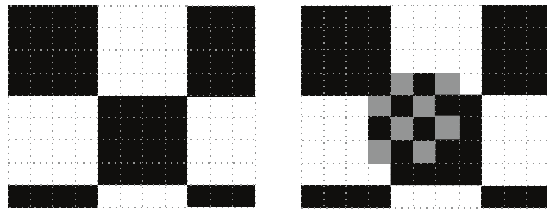
Figure 1: Macroblock grid without (left) and with the ROI